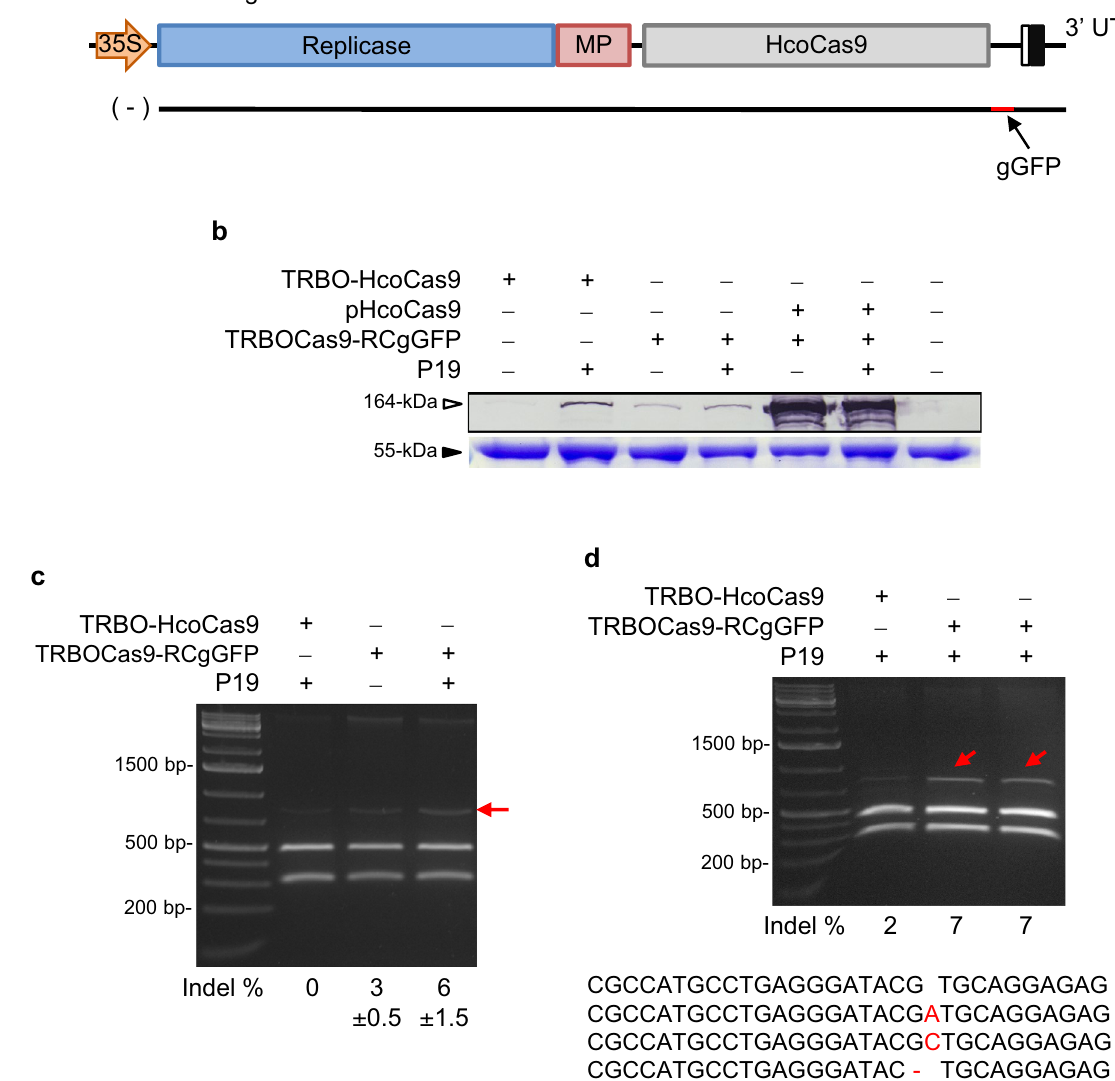
Figure 6. Delivery of CRISPR/Cas9 components using a single TRBO vector. ( a ) Vector construct TRBOCas9- RCgGFP with gGFP expressed through the (−) sense RNA. ( b ) Western blot analysis of the Cas9 protein delivered using the TRBOCas9-RCgGFP and compared to other delivery vectors as indicated. ( c ) Bsg I restriction assay detecting gene edited resistant band (red arrow) by the functional Cas9 protein and sgGFP of TRBOCas9-RCgGFP. ( d ) Sequence analyses of gene edited resistant bands (red arrows) showed various nucleotide indels at the Bsg I target